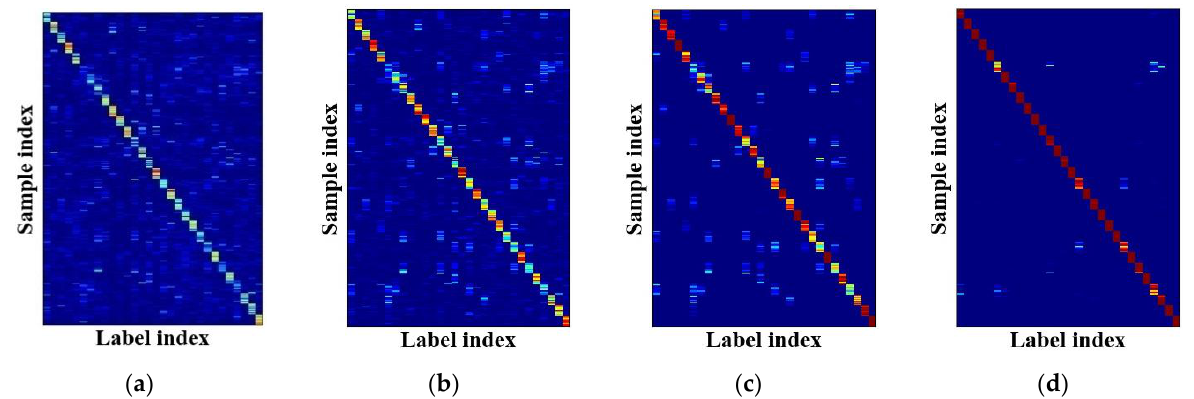
Figure 14. Label distributions that are produced by our method using different α z . ( a ) when α z = 0.1, N d = 318; ( b ) when